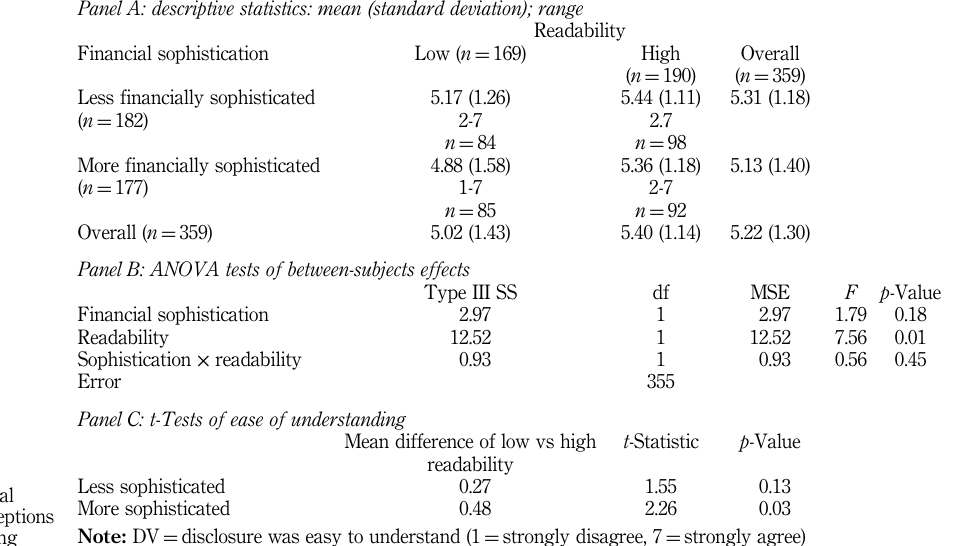
investors ’ perceptions of